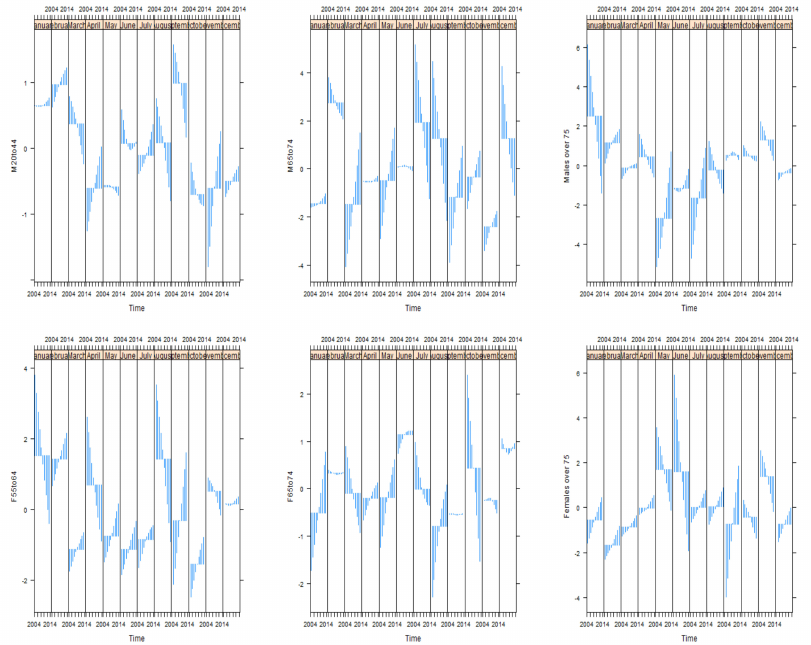
Figure A3. Cycle-subseries plots for all age-gender specific